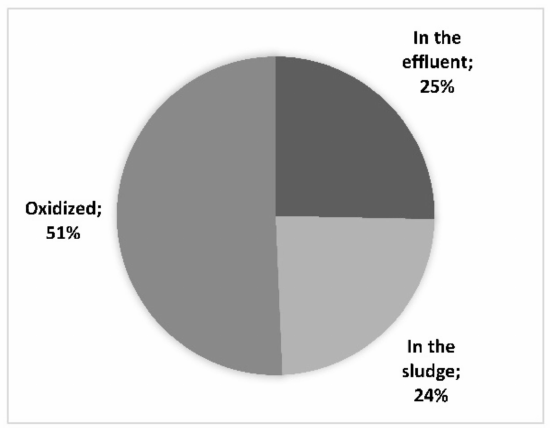
Figure 4. Mass balance of the COD entering the side-stream plant. The percentages represent the destiny of the fractions of entering COD.